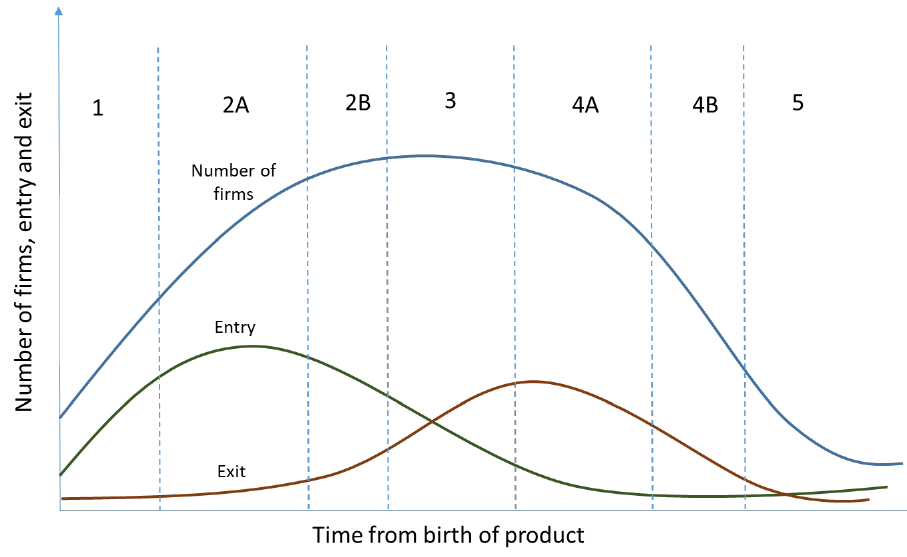
Figure 1. Entry, exit and number of firms across the industry life cycle stages.